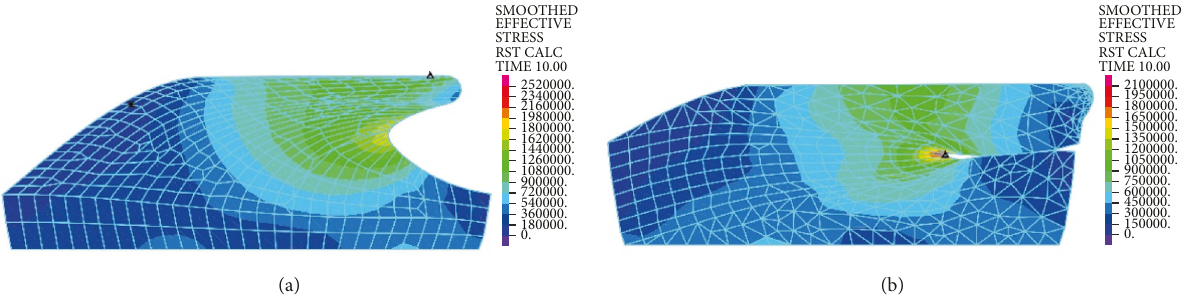
Figure 5: Effective stress contrasting: (a) before optimizing and (b) after optimizing.